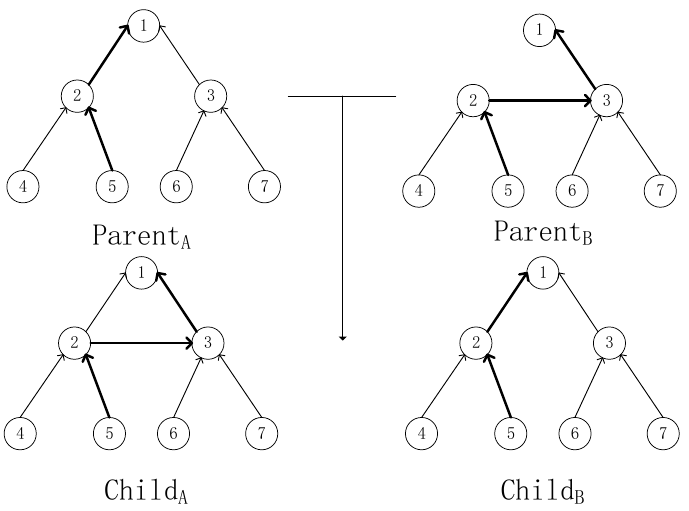
Figure 7. Topology loop after the cross operation.